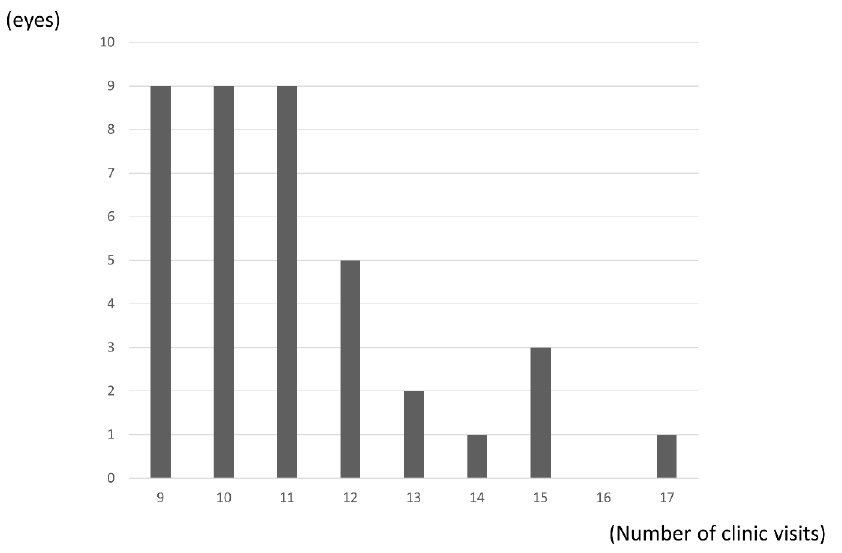
Figure 5. Distribution of number of clinic visits. Mean number of clinic visits was 10.1 (2.0) over the 24 months.